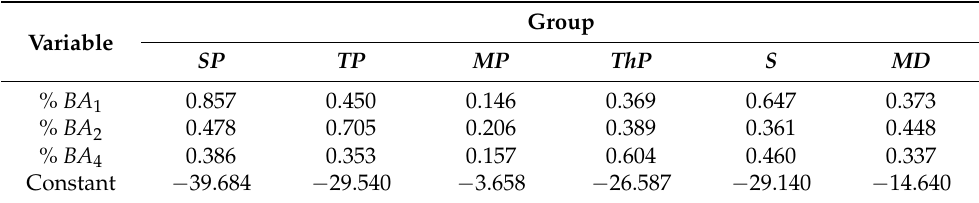
Table 4. Coefficients of the Fisher classification functions for second DA ( SP : Seedling Poles; TP : Thin Poles; MP : Medium Poles; Th : Thick Poles; S : Stratified; MD : Multi-diameter).